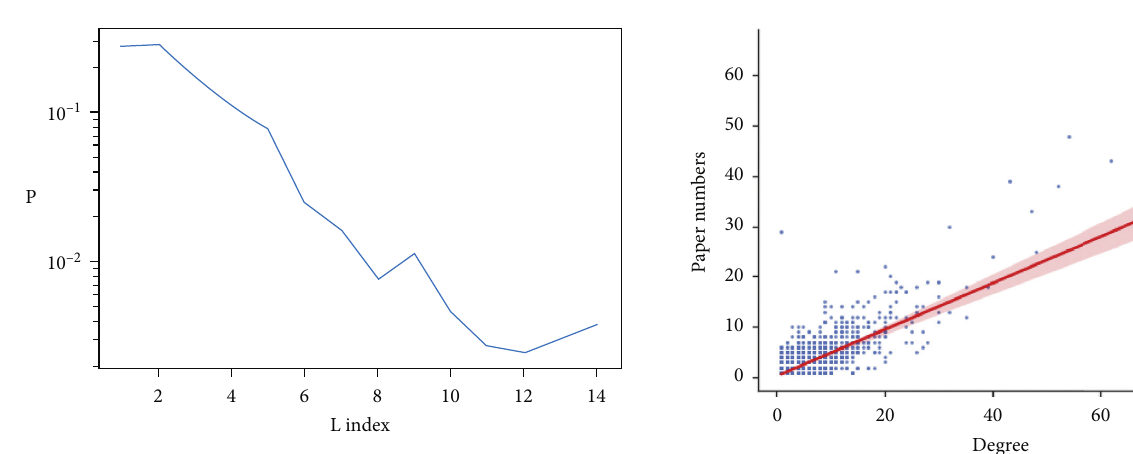
Figure 5: Distribution of L-index.